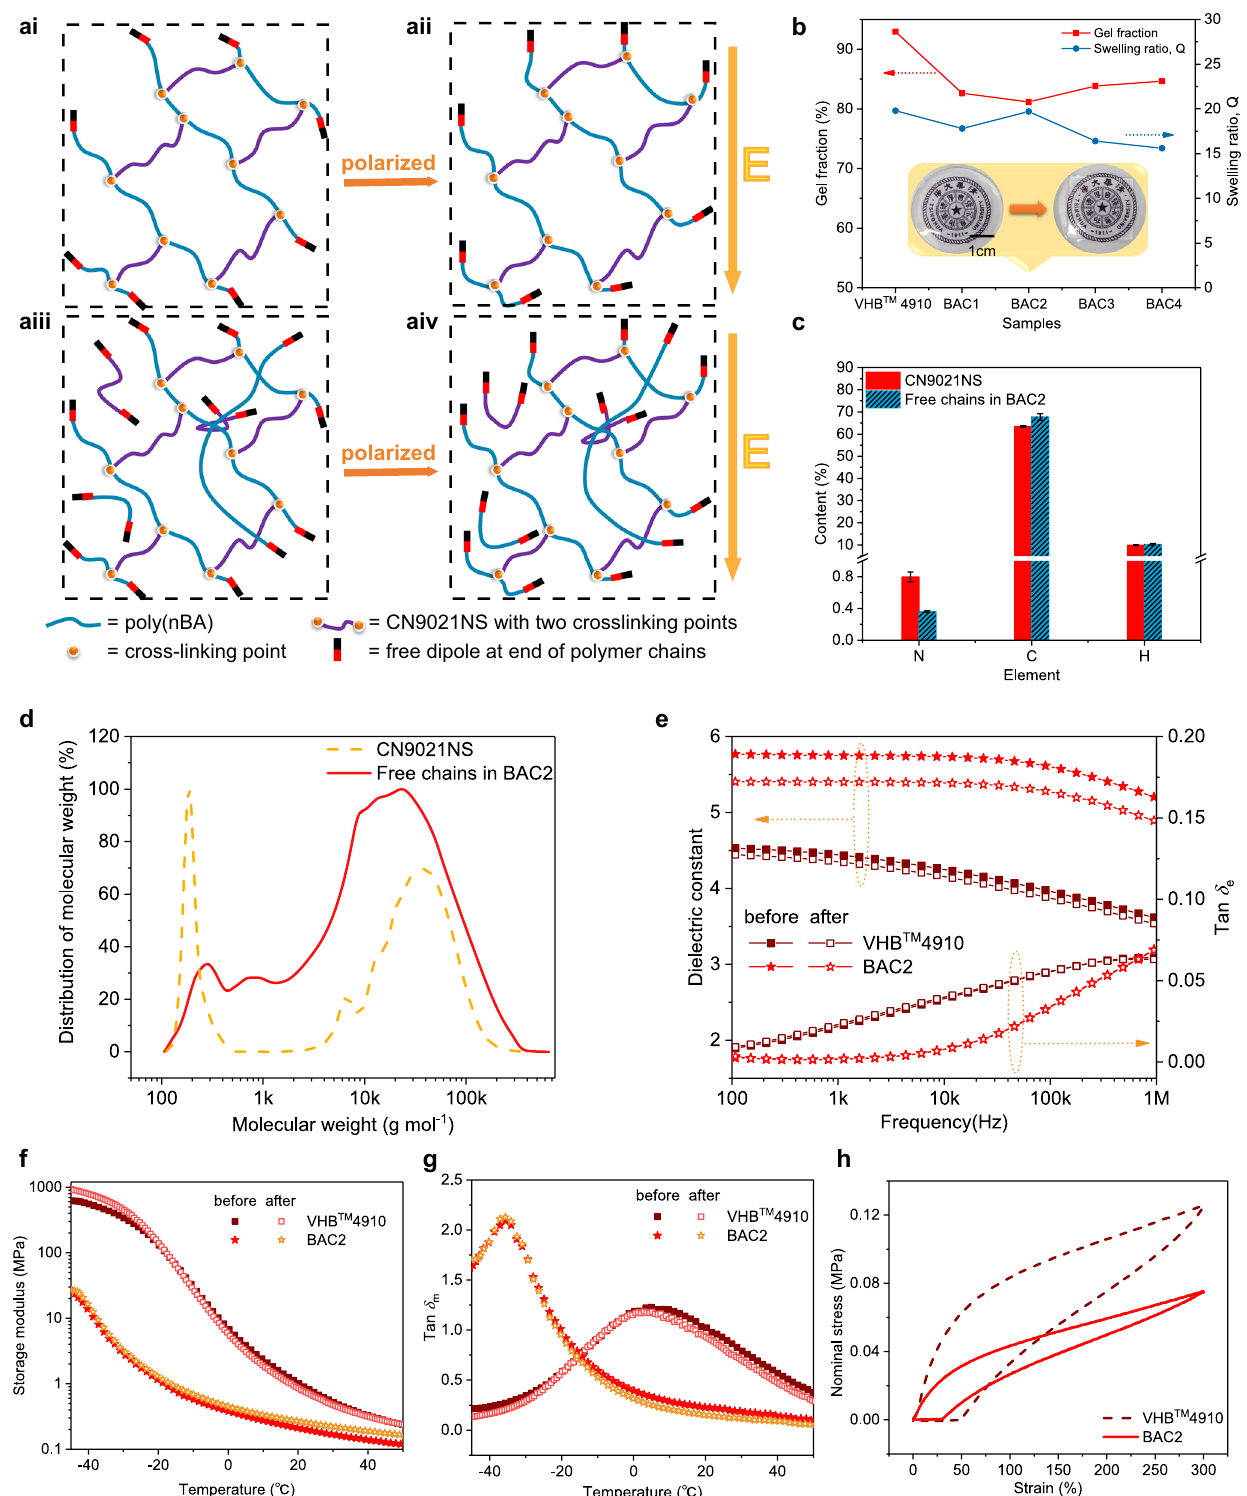
Fig. 2 In fl uence of chemically uncrosslinked chains on dielectric and mechanical properties. a Schematic comparison of the polarization process of acrylic elastomer without uncrosslinked chains ( ai , aii ) and BAC2 sample with a considerable amount of uncrosslinked chains ( aiii , aiv ). b Gel fraction and swelling ratio of VHB TM 4910 and synthesized elastomers. The insets show the optical images of BAC2 sample before and after swollen. c Elemental analysis comparison between CN9021NS and free chains of BAC2 after swollen. At least three samples were tested for the calculation of average value and standard deviation. d Molecular weight distribution of CN9021NS and free chains of BAC2 after swollen. e Frequency dependence of dielectric constant and dissipation factor (Tan δ e ) of VHB TM 4910 and BAC2 before and after swollen in the range of 10 2 – 10 6 Hz. f , g Storage modulus ( f ) and mechanical loss (Tan δ m ) ( g ) as a function of temperature of VHB TM 4910 and BAC2 before and after swollen. h The cyclic stress – strain curves of VHB TM 4910 and BAC2 at a stretch rate of 100 mm min − 1 . The area encircled by the curve indicates the dissipated mechanical